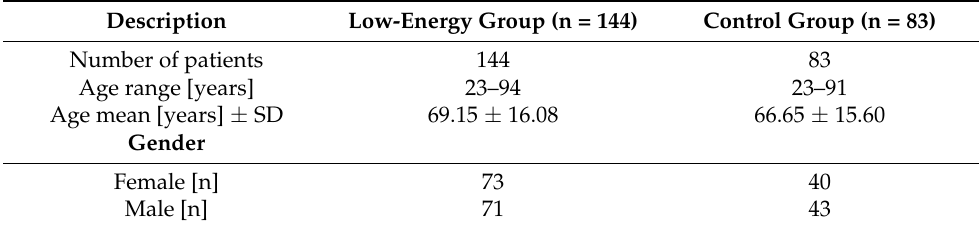
Table 1. Baseline characteristics of the populations.